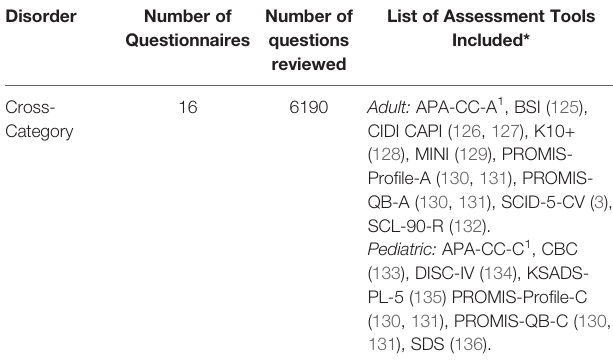
TABLE 1 | Overview of Questionnaires and Interviews included in the